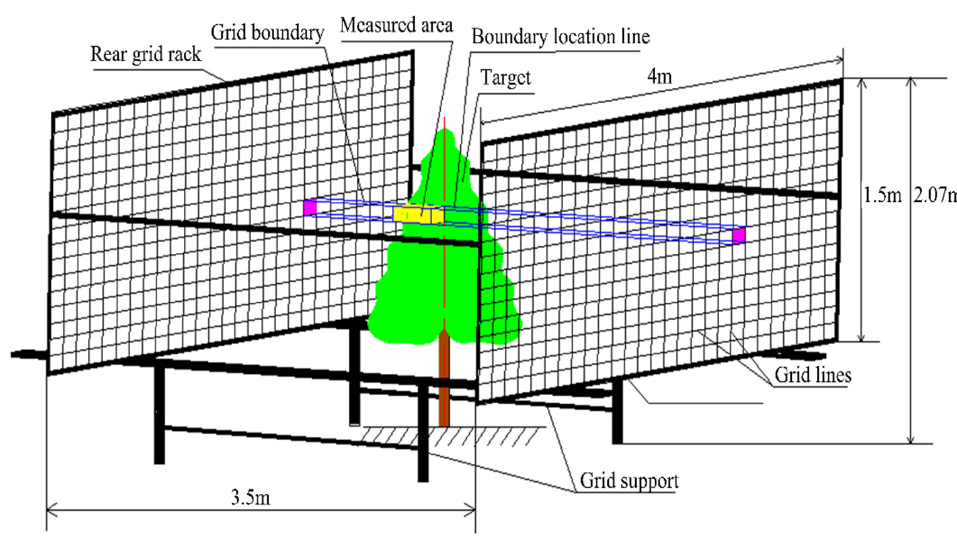
Figure 2. Schematic diagram of the three-dimensional experimental platform structure and measurement method for canopy leaf area.